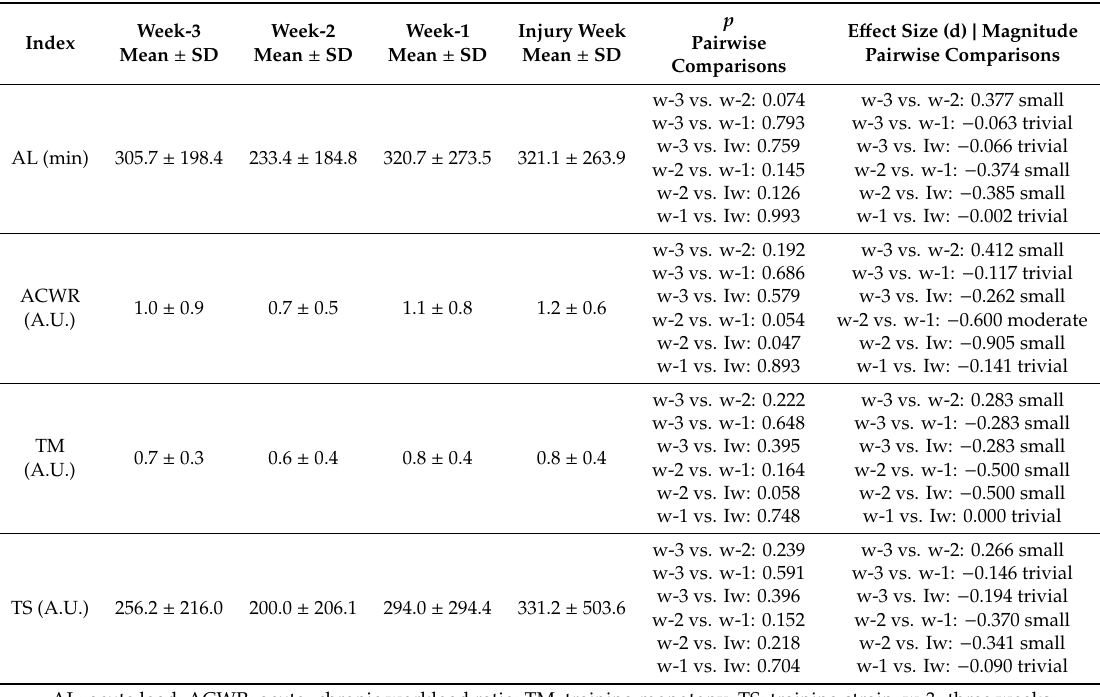
Table 2. Between-weeks variations of workload indices based on training time before